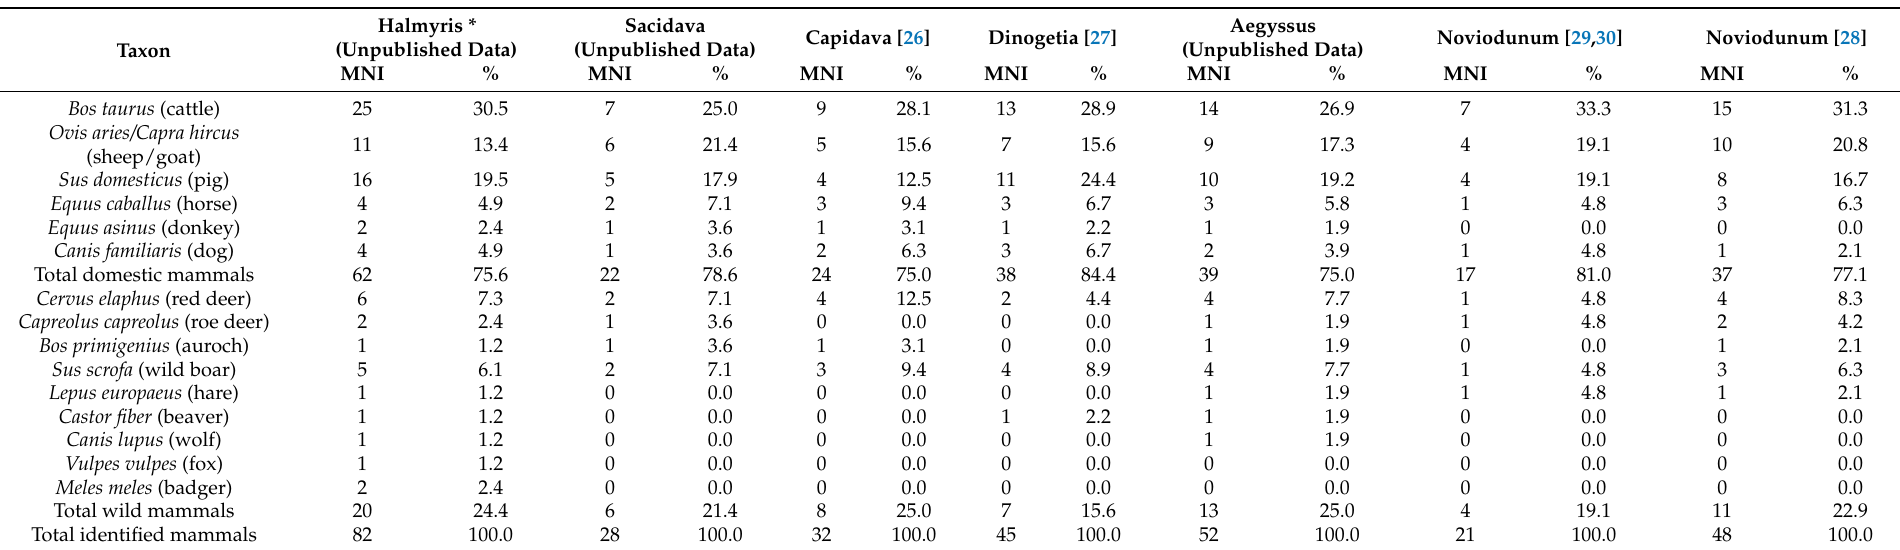
Table 5. Quantification of mammal remains by MNI (minimal number of individuals) in the assemblages. * Quantification of mammal remains by MNI is not complete in the publications of El Susi